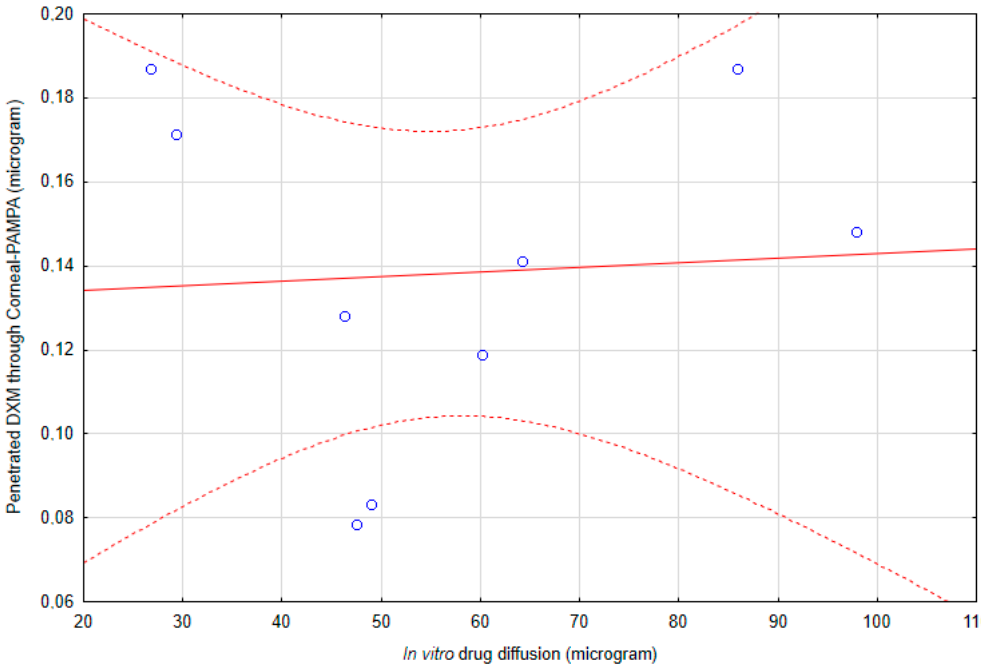
Figure 13. The correlation of the in vitro diffusion study and penetrated amount of DXM through Corneal-PAMPA.